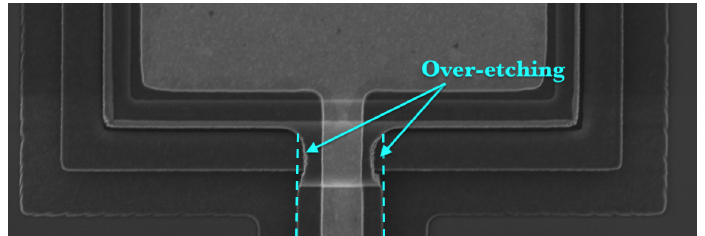
Figure 4. Defects of microfabrication